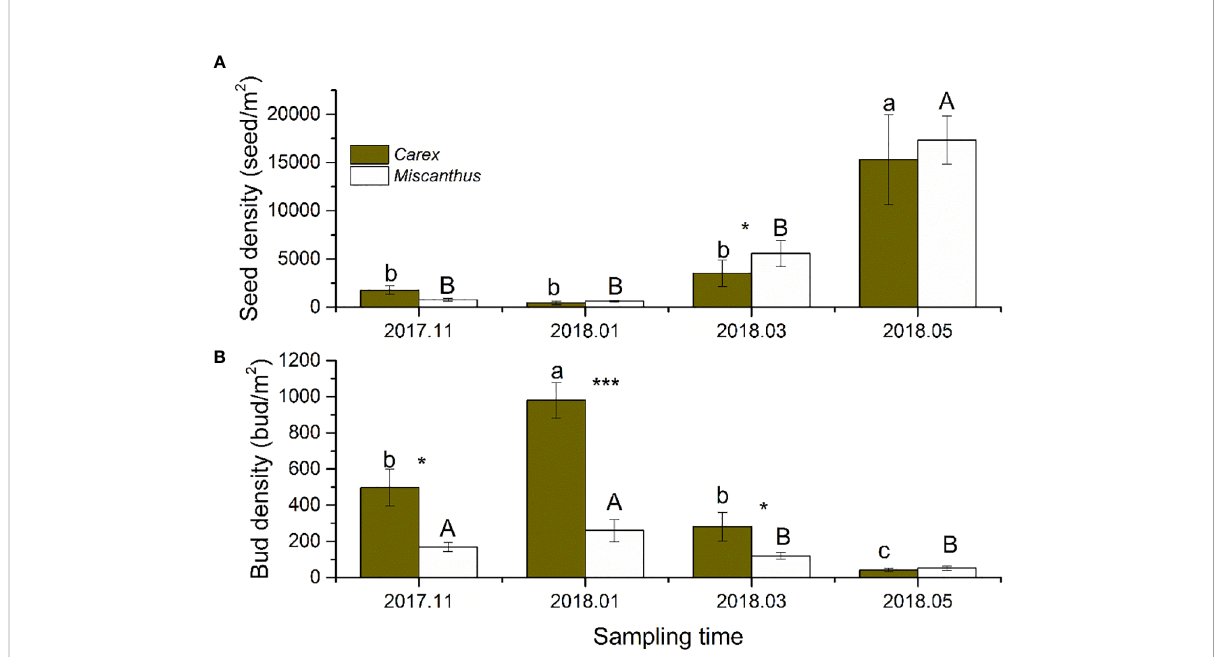
FIGURE 2 Seed and bud densities of the two dominant macrophytes in four sampling periods. Different lower-case and upper-case letters indicate differences at the 0.05 signi fi cance level for Carex and Miscanthus community respectively. Asterisk indicate signi fi cant differences between Carex and Miscanthus community.* P < 0.05, and *** P <